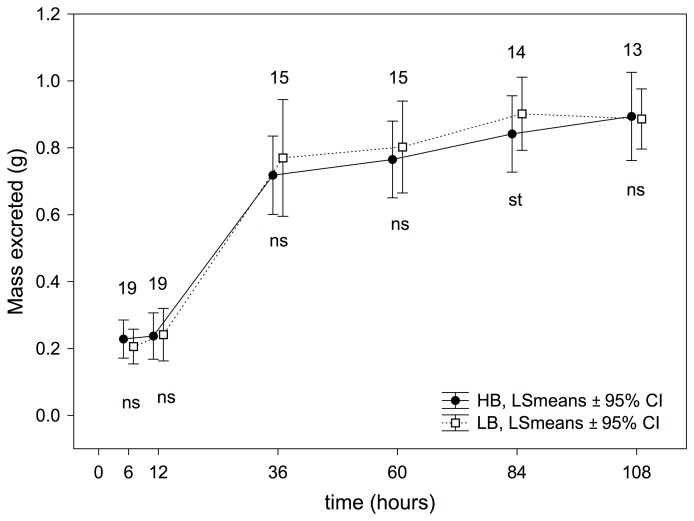
Effect of the experimental treatment on mass excreted by nestlings based on the RM-ANOVAs for each experimental session.P-values associated to LSD post hoc test are indicated as ns: P>0.05; st: 0.1≤P≥0.05; *: P<0.05; **: P<0.001 and ***: P<0.0001. Numbers of nests (i.e. those with measurements from the four nestlings) used in each comparison are also shown.